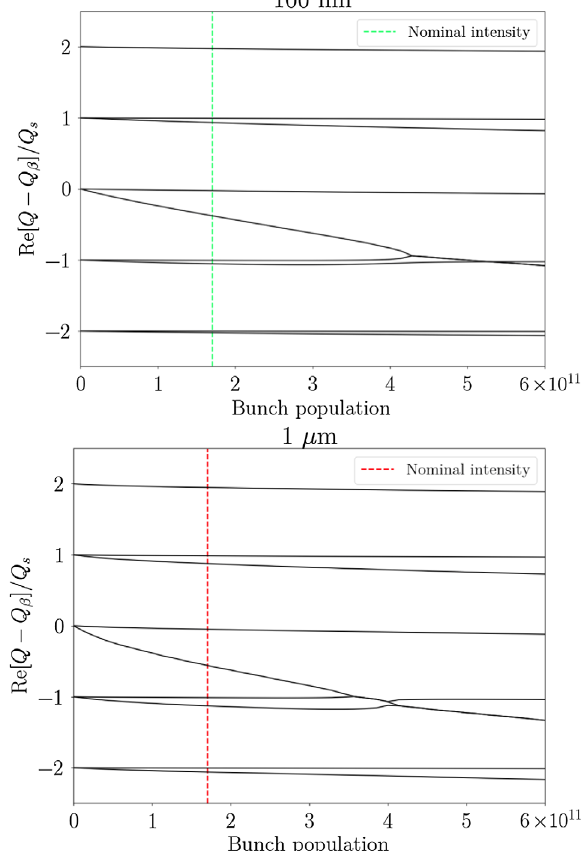
FIG. 6. Real part of the tune shift of the first coherent oscillation modes as a function of the bunch population for 100 nm (top) and 1 μ m (bottom) thicknesses. The dashed lines represent the nominal bunch